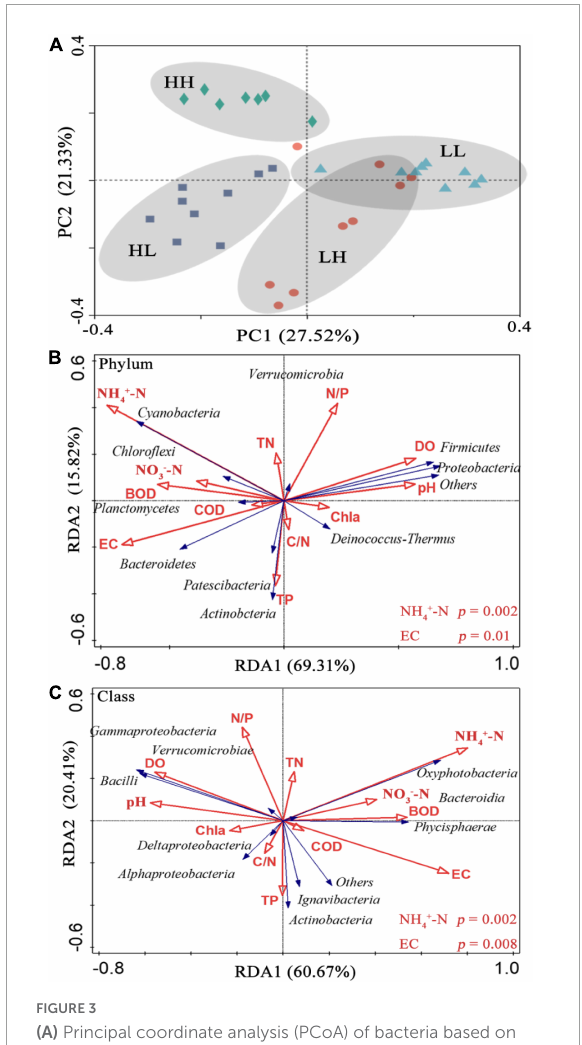
FIGURE3 (A) Principal coordinate analysis (PCoA) of bacteria based on Bray–Curtis dissimilarity in freshwater of the four wetlands; redundancy analysis (RDA) diagram illustrating the relationships between the compositions of freshwater bacteria at the (B) phylum, and (C) class levels from different sampling sites with variable environments. Blue arrows show bacterial community composition; red arrows show physicochemical properties in the